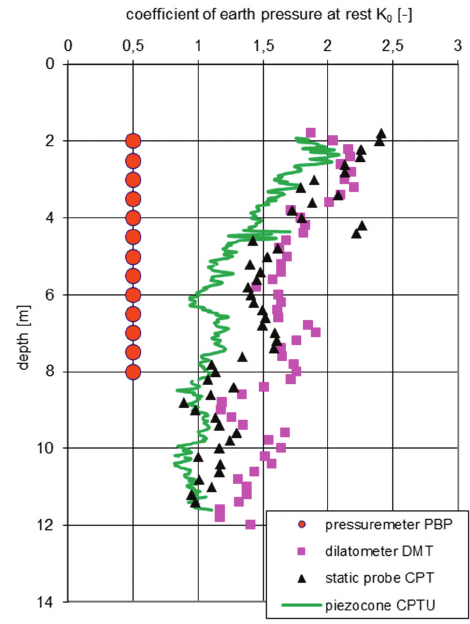
Fig. 13. Coefficient of earth’s pressure at rest in the study